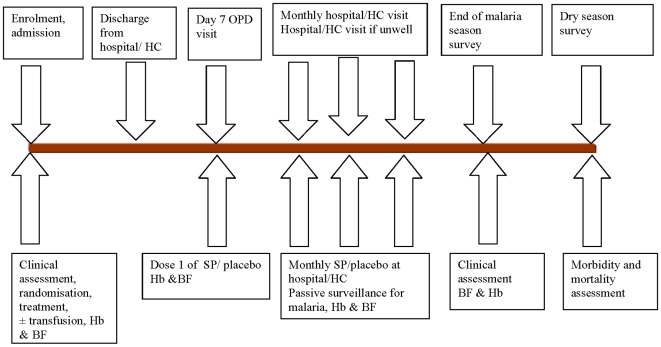
Overall study design.The duration of follow up varied depending upon the time in the malaria transmission season when a child was recruited. OPD = outpatient department; Hb = haemoglobin; BF = blood film.